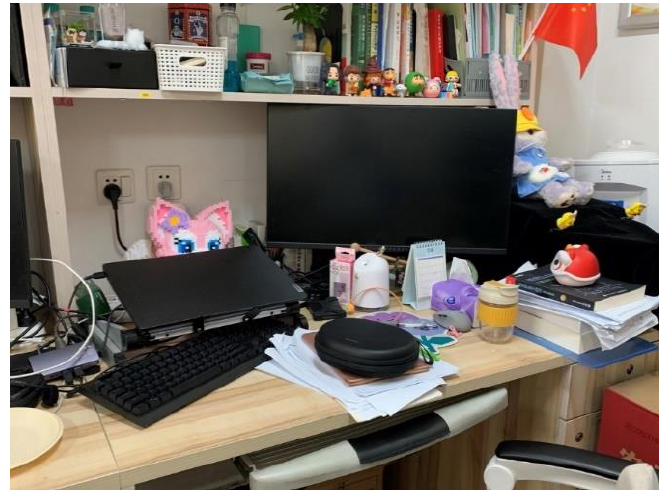
Figure 11. Image of experimental scene.